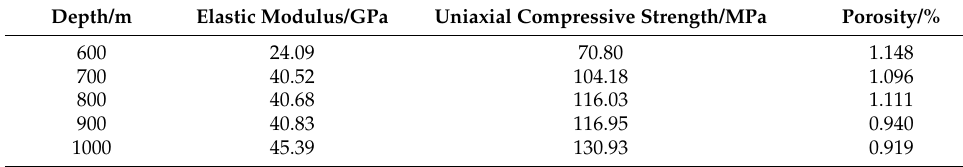
Table 1. Physical and mechanical